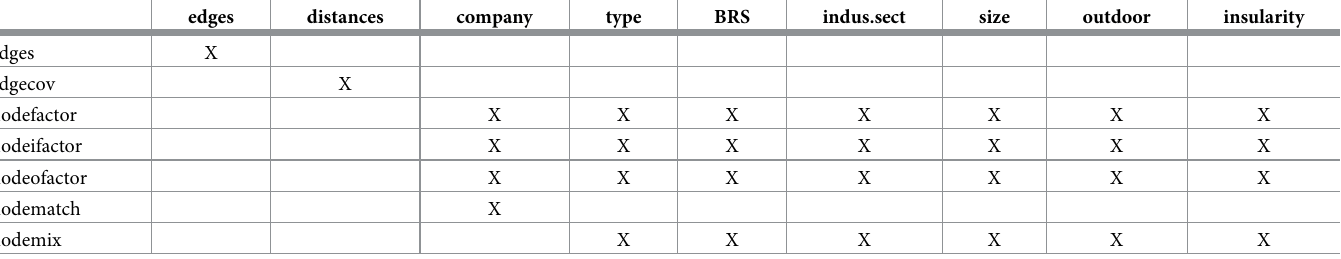
Table 4. Network statistics included in the forward stepwise process for exponential random graph model selection. Network attributes in columns were associated with one to five exponential random graph terms (rows). Attributes and terms are described in Tables 5 and 6.